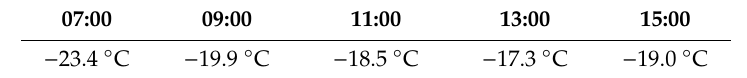
Figure 17. The procedure of rush-repair construction. Table 4. The ambient temperature measured at the construction